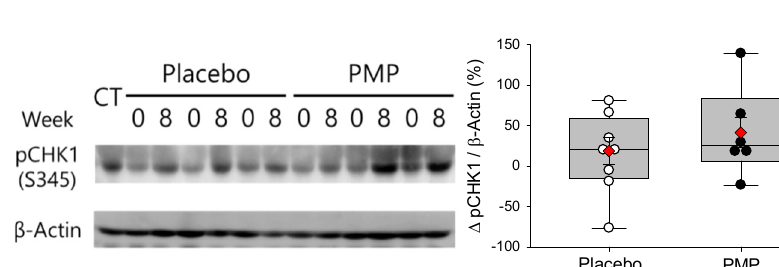
Figure 2. Effect of eight-week supplementation on DNA damage and repair: ( A ) Comet assay on PBMC;